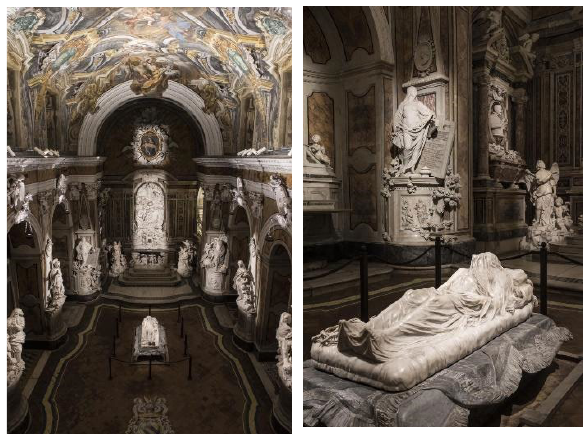
Figure 2. Sansevero Chapel. A detail of the vault’s